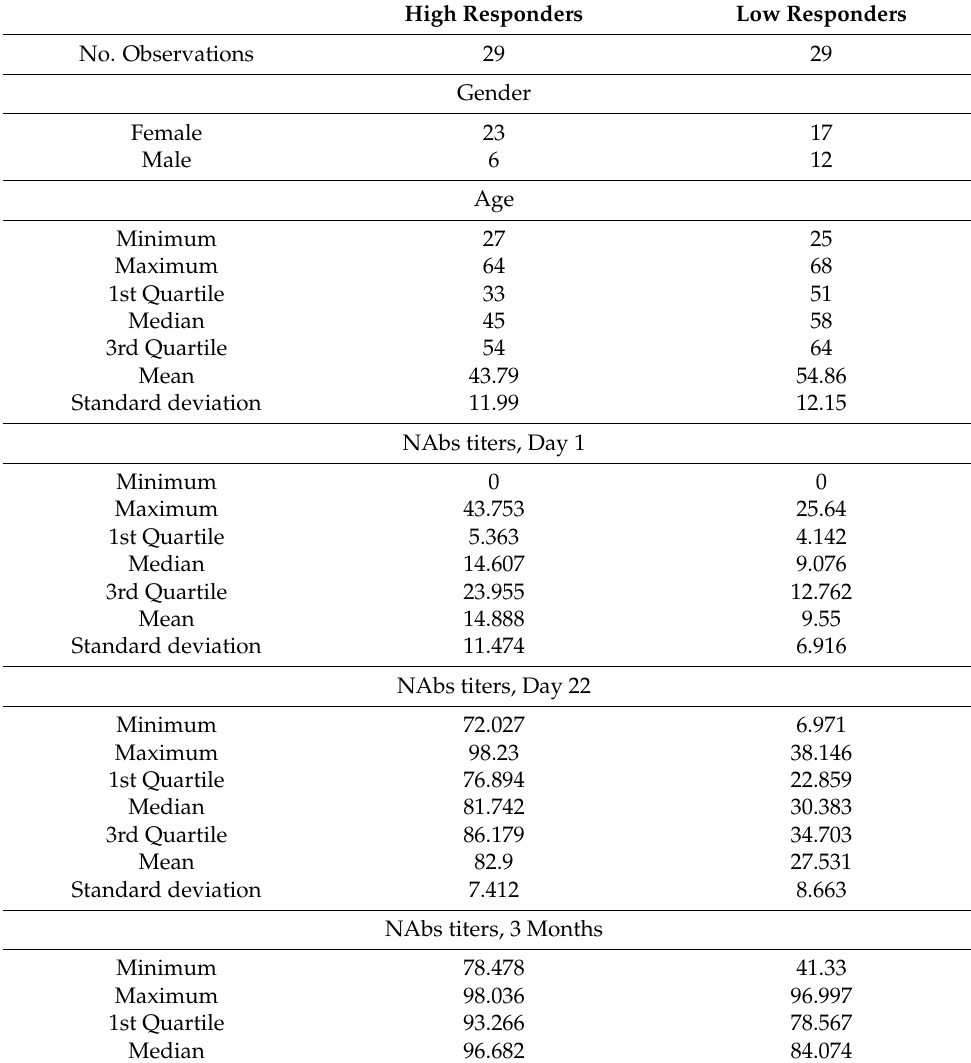
Table 1. Demographic characteristics and number of antibodies for the participants enrolled in this study for each of the “Low” and “High” response